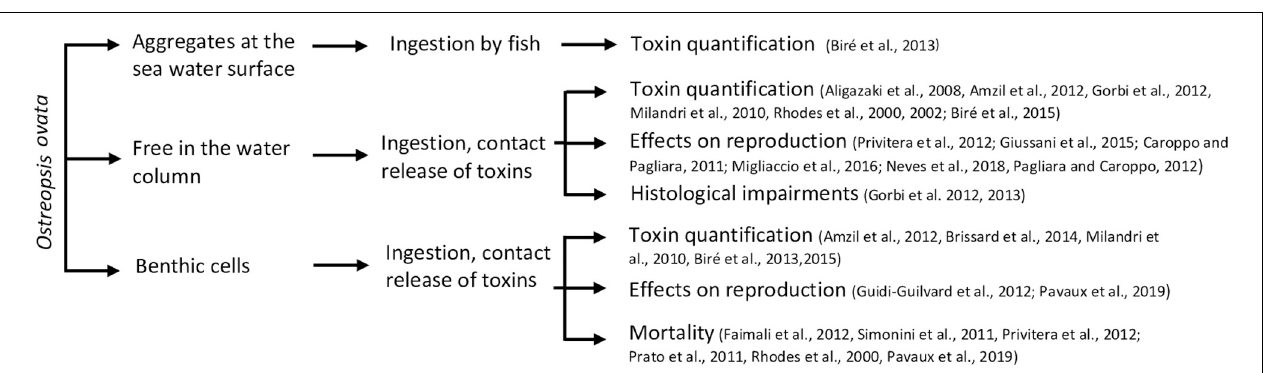
FIGURE 4 | Summary of direct interactions of Ostreopsis ovata and